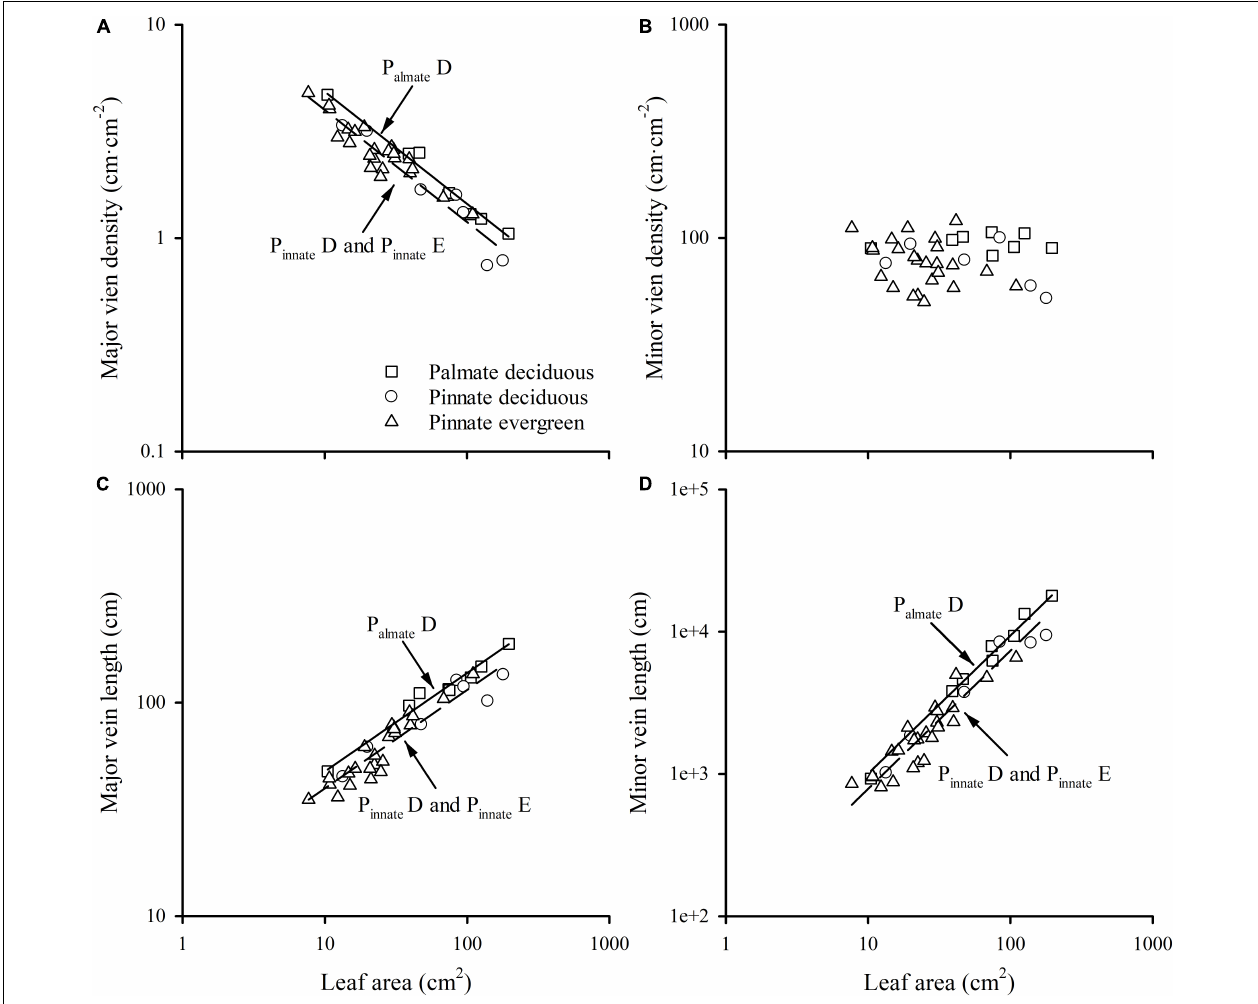
FIGURE 1 | The relationships of the major vein density (A) , the minor vein density (B) , the major vein length (C) , and minor vein length (D) with leaf area across different group species. P almate D, plamate-veined deciduous species; P innate D, pinnate-veined deciduous species; and P innate E, pinnate-veined evergreen